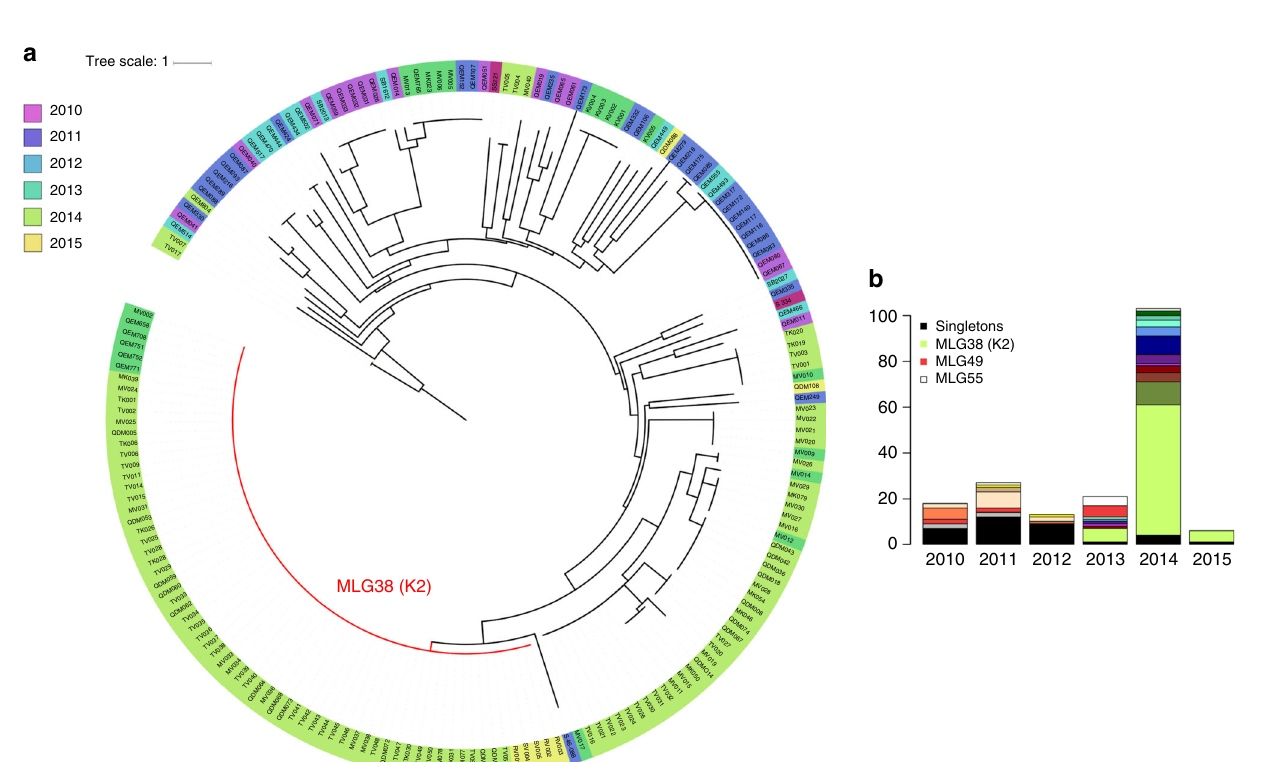
Fig. 6 Temporal trends in the relatedness of Sabah P. vivax isolates using the microsatellite data. a A neighbour-joining tree illustrating trends in the relatedness of P. vivax infections between 2010 and 2015. Data are presented on 187 P. vivax isolates with complete MLGs across the nine microsatellite loci. b A bar plot illustrating temporal trends in the frequency of different MLGs between 2010 and 2015. Colour coding re fl ects distinct MLGs with the exception of singly observed (singleton) MLGs, which were grouped together for simple visual representation (back bars). MLG38 (genomic K2 strain) was the most frequent MLG observed in the dataset. MLGs 49 and 55 persisted for at least 4